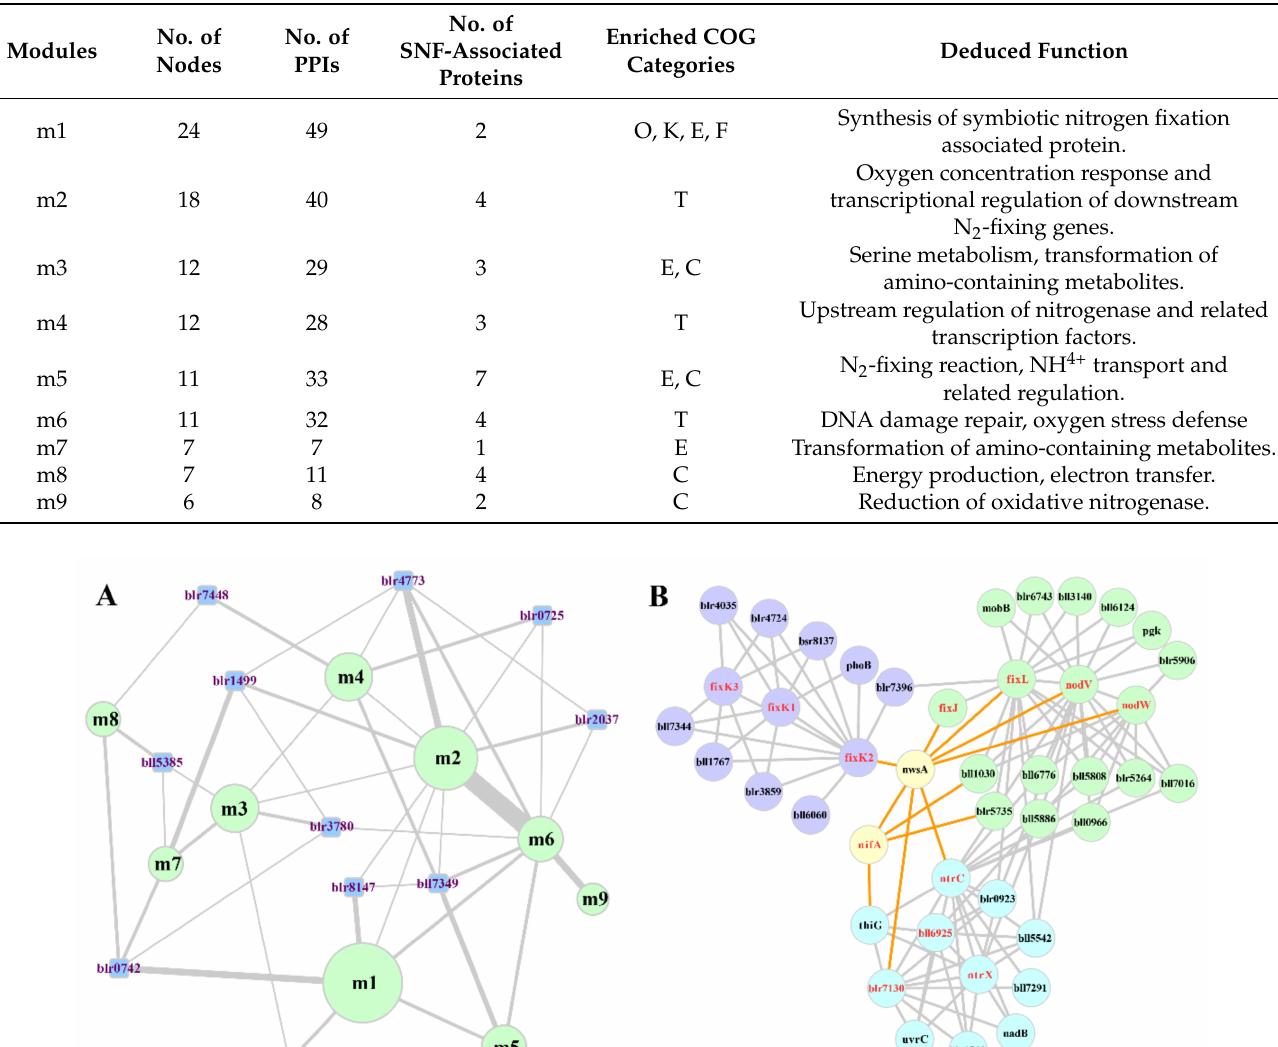
Table 2. Deduced functions of the network modules identified by MCL clustering.